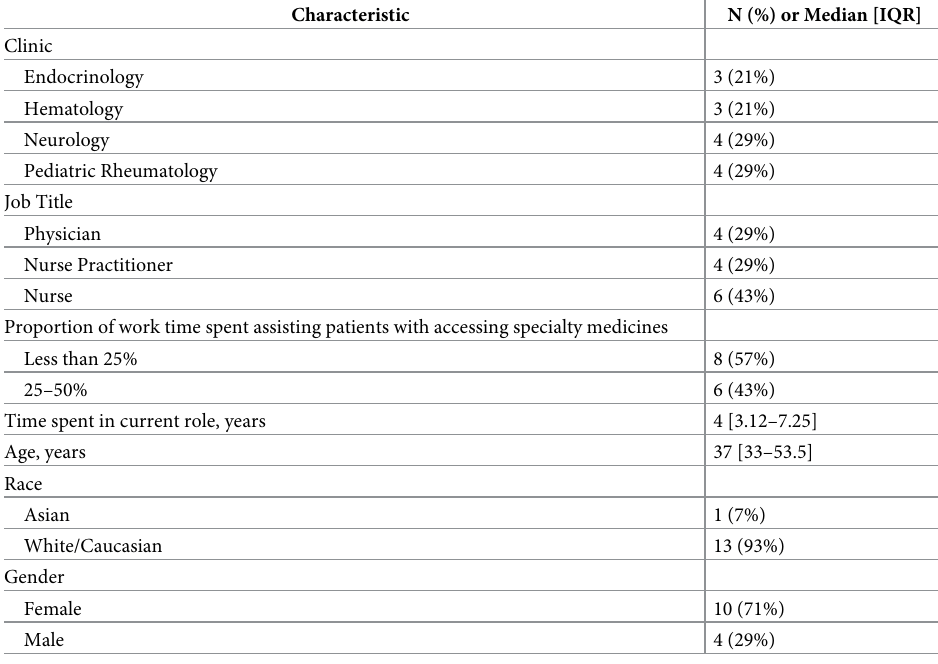
Table 1. Characteristics of the sample (n =